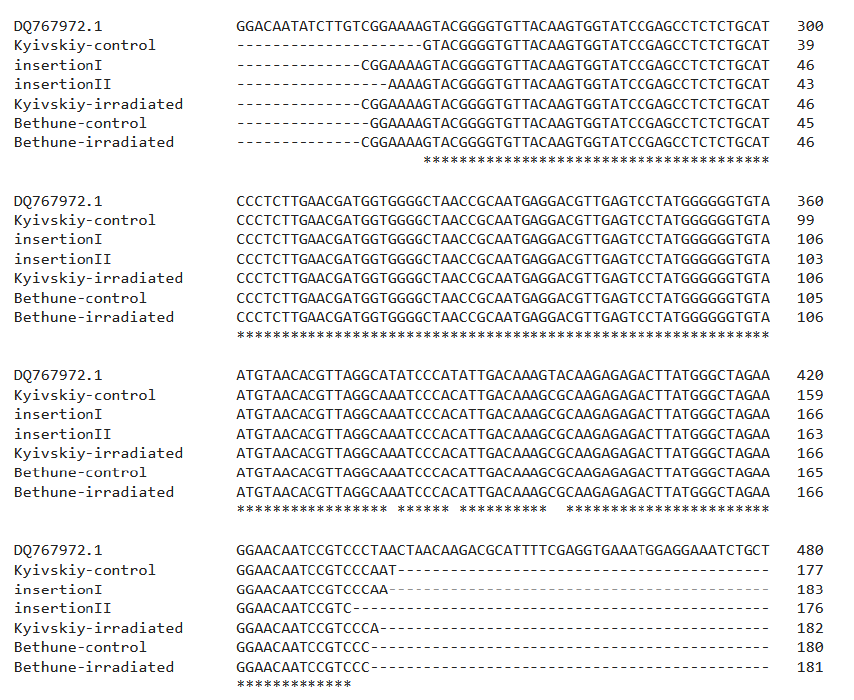
Figure 3. Sequence alignment by Clustal Omega of Cassandra amplicons generated in selected TRIM Cassandra fingerprints of common flax varieties Kyivskyi and Bethune grown in the remediated and radio-contaminated field conditions of Chernobyl.